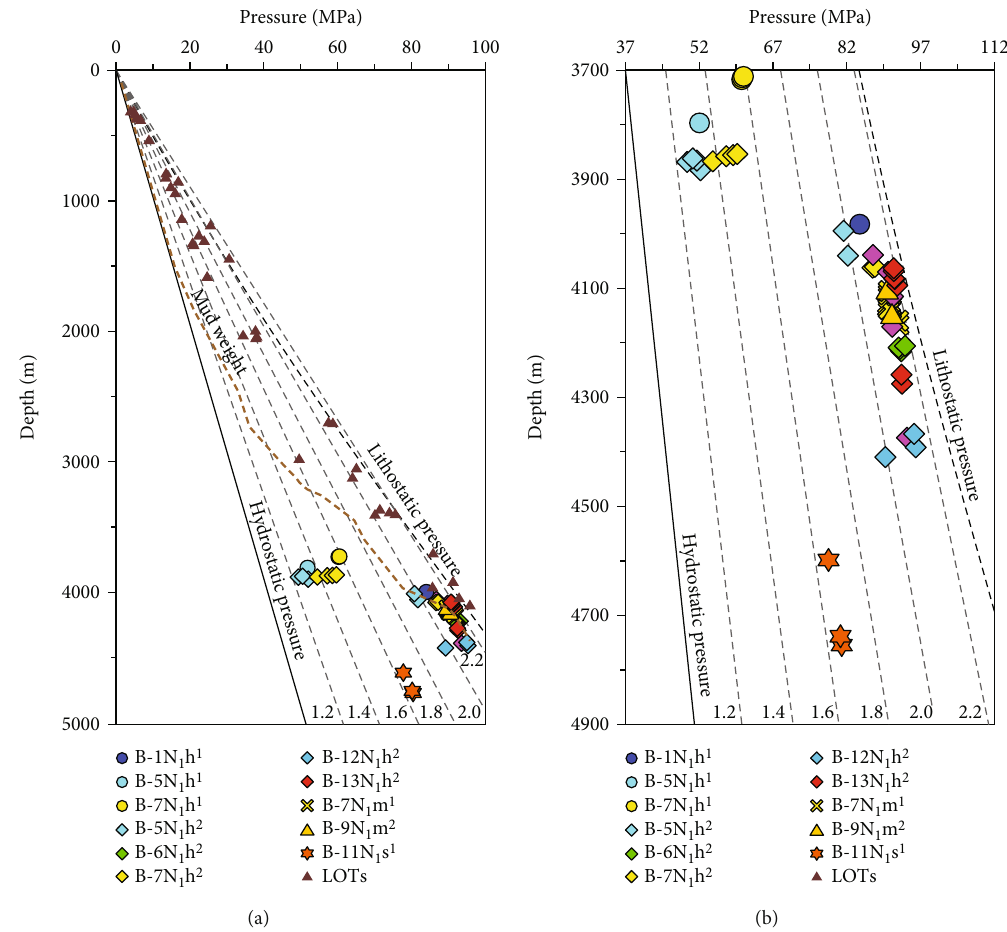
Figure 5: Pressure in the reservoir versus depth plot of the LD-B Wellblock. Pressure data are from the DST and MDT, and LOTs mean leak- o ff pressures. (b) is a local enlargement of